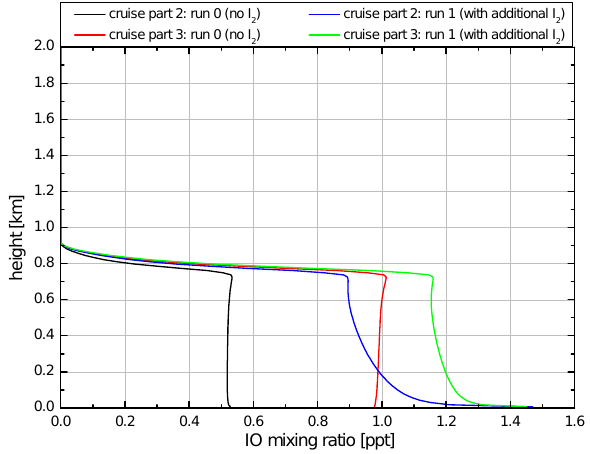
Fig. 10: IO vertical profiles for different model scenarios (run 0, run 1) for cruise part 2 Fig. 10. IO vertical profiles for different model scenarios (run 0, run and 3 at 12:00 local time. 1) for cruise part 2 and 3 at 12:00 local